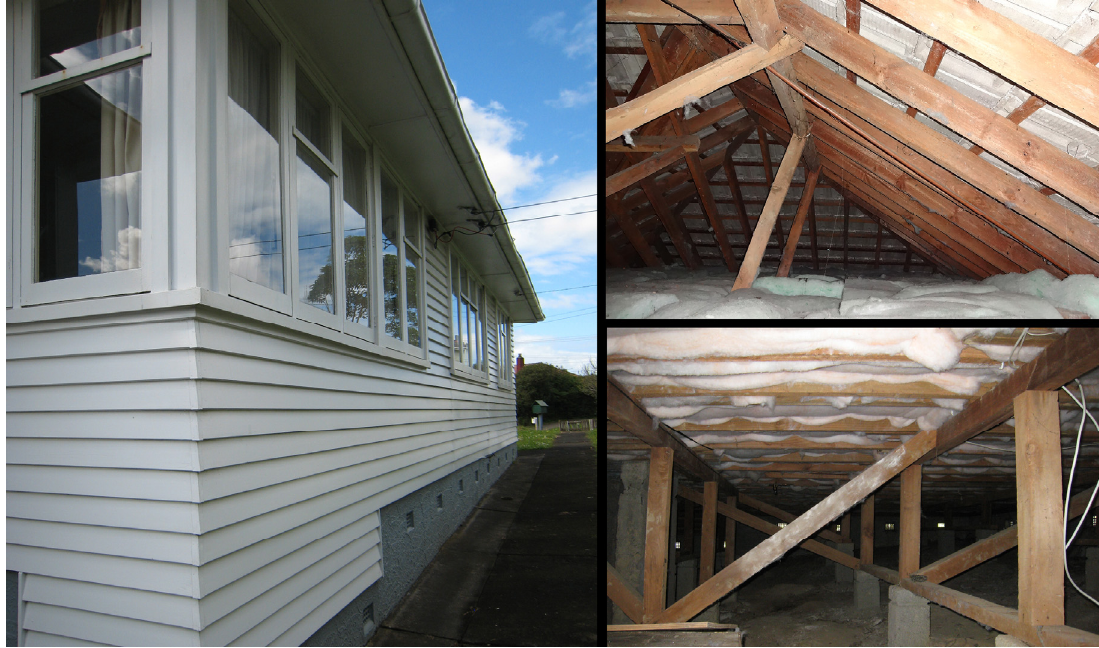
Figure 4. North-west facades , hipped roof cavity (timber rafters with concrete tiles and polyester insulation) and basement cavity (jack studs, sleepers and bracing struts on concrete blocks supporting floor joists with polyester insulation in-between) of the pilot project house in